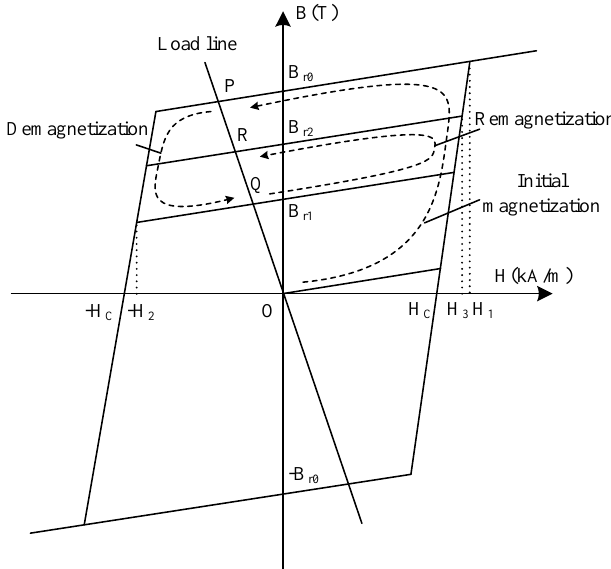
Figure 3. Piecewise linear hysteresis model of AlNiCo PM.